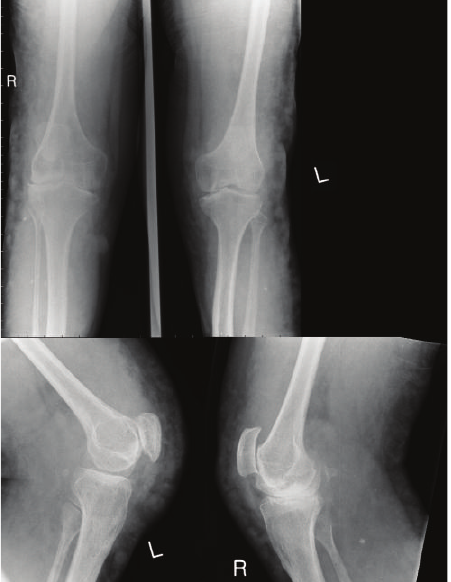
Figure 1: AP and lateral radiographs of the patient’s knees at age 21.